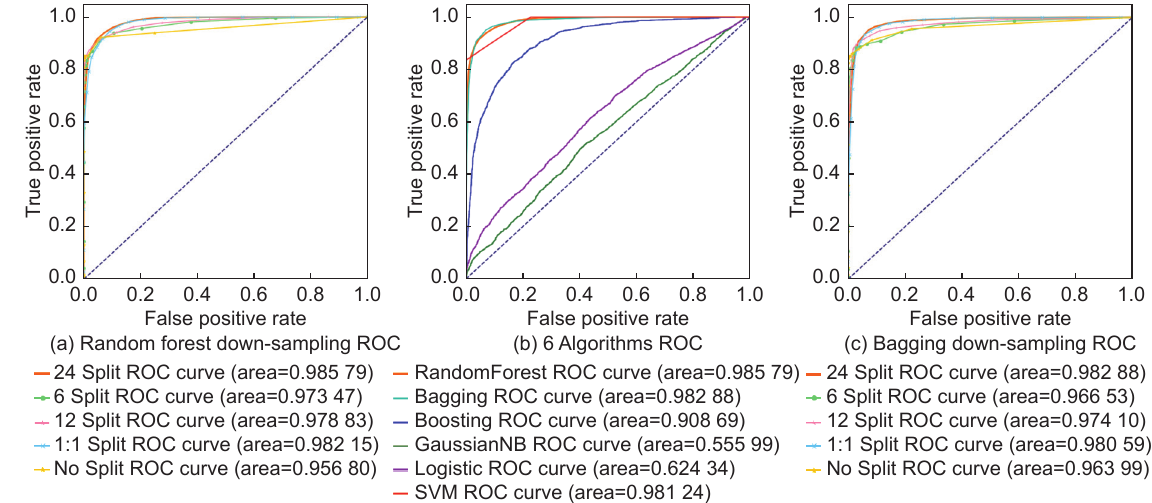
Fig. 2 ROC curves of RF with different split strategies and different